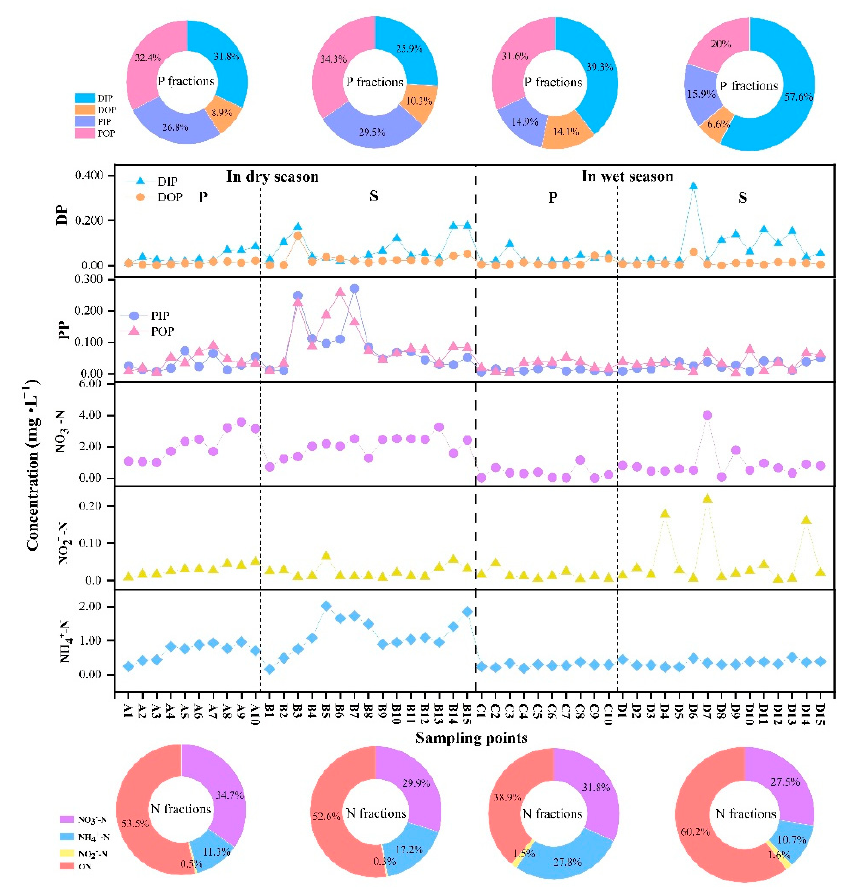
Figure 5. N and P fraction concentration distribution in water in the study area. (P: Pi river, S: Shiting river).